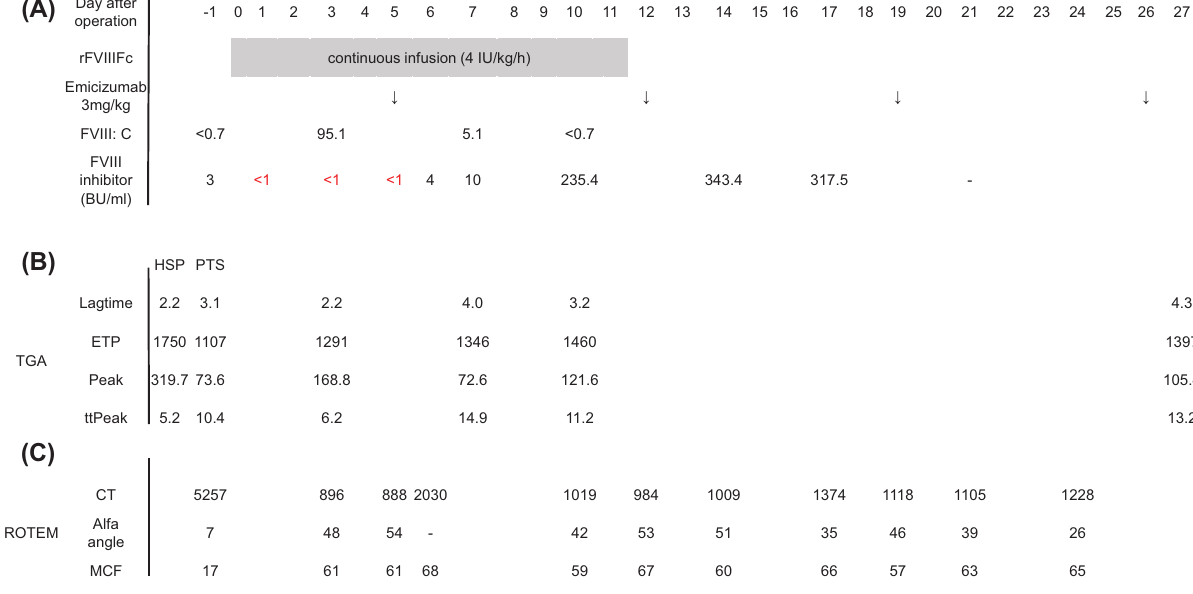
Fig. 1 The patient ’ s clinical course and results of thrombin generation assay (TGA) and rotational thromboelastometry (ROTEM). Chromogenic substrate assayforFVIII:CandtheBethesdaassayforFVIIIinhibitorsweremodi fi edtoavoidthein fl uenceofemicizumab. 7 Inhibitorswerebelowmeasurementsensitivity ondays1,3,and5andweredetectedonday6,atatiterof4BU/mL.FVIII:Cdecreasedtobelowassaysensitivitylimitsonday10,inspiteofcontinuousinfusion ofrFVIIIFc.Emicizumabwas fi rstadministeredonday5atadoseof3mg/kg,thisdosebeingadministeredfourtimesatweeklyintervals,followedby1.5mg/kg weekly.( A )TGA:TGAwasperformedusingcitratedplatelet-poorplasma(PPP)fromthepatient,extractedusingaPPPreagent.Theprocedurewasperformed using calibrated automated thrombography (Thrombinoscope BV; Finggal link, Tokyo, Japan), in accordance with the manufacturer ’ s instructions. We monitoredreactionsfor1hour,usingaFluoroskanAscentFLmicroplate fl uorometer(ThermoFisherScienti fi c,Tokyo,Japan),setatanexcitationwavelengthof 390nm and an emission wavelength of 460nm, and Thrombinoscope software (Thrombinoscope BV). The wave shapes of TGA and an explanation of the parametersareshownin ► Supplementary Fig. S1 .( B ) ROTEM:The NATEMmodewasusedinthisstudy, whichisreportedlymore informativethanEXTEM andINTEMmodesinpatientsbeingtreatedwithemicizumab. 8 Bloodsampleswerecollectedinatubecontaining3.2%trisodiumcitrate.Wholeblood(300µL) wasmixedwith20µLofstar-TEM(CaCl 2 ; fi nalconcentration,12.5mM),thenanalyzedusingawhole-bloodhemostasisanalyzer.Thecoagulationprocesswas assessed using clotting time (CT; time from start of measurement until detection of clot fi rmrmness at 2-mm amplitude), α angle (angle of the tangent between0mmandthecurvewhentheclot fi rmnessis20mm),andmaximumclot fi rmness(MCF, fi rmnessoftheclotandclotquality)( C ).CT,clottingtime; ETP,endogenousthrombinpotential;HSP,humanstandardplasma;MCF,maximumclot fi rmness;PTS,pretreatmentstate;rFVIIIFc,recombinanthumanfactor VIII Fc fusion protein; ROTEM, rotational thromboelastometry; TGA, thrombin generation assay; ttPeak, time to